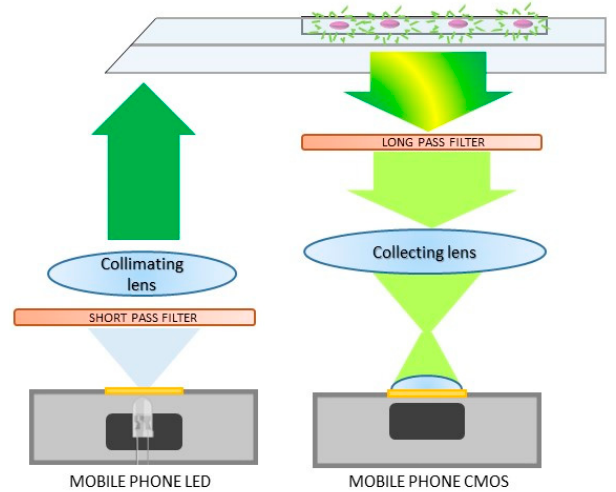
Figure 4. Optical scheme employed in the fluorescent cytometer to excite and collect the fluorescence signal by exploiting the built-in LED and CMOS camera of a mobile device.